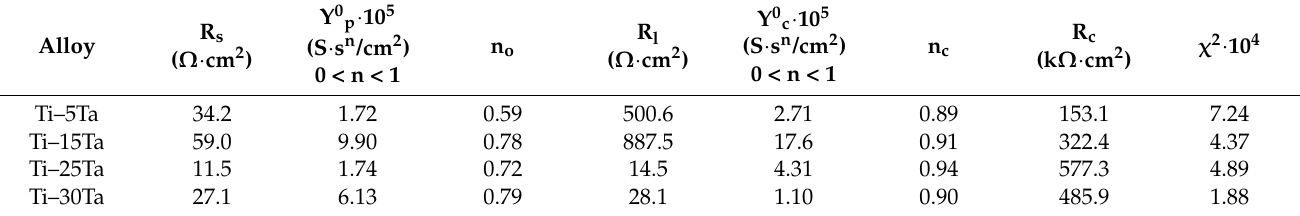
Table 5. Circuit parameters calculated from the fitting of the EIS spectra at corrosion potential to the equivalent circuit from Figure